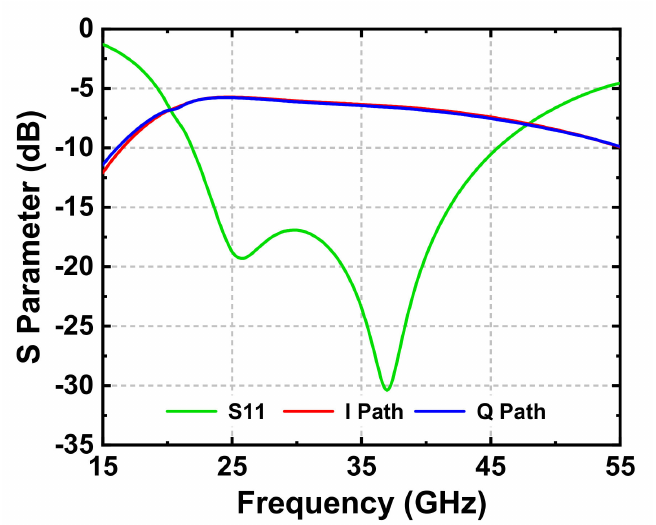
Figure 13. S-parameters of the proposed ultra-wideband I/Q signal generation